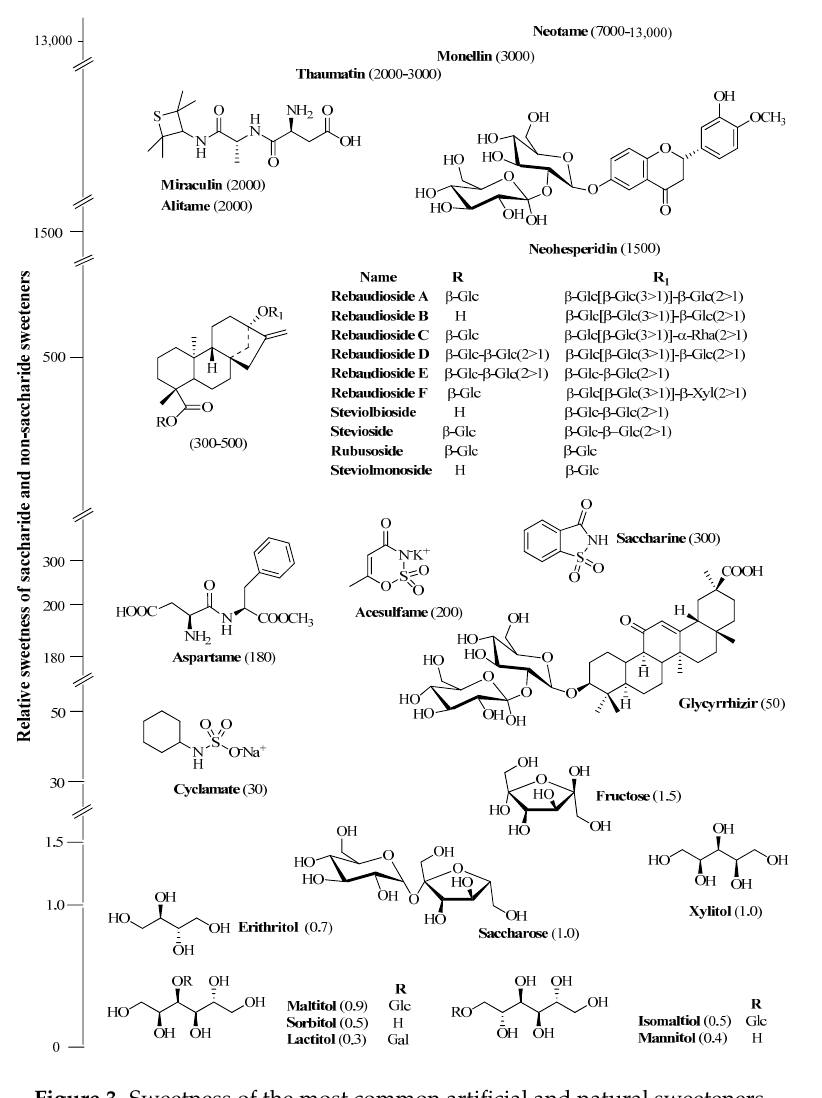
Figure 3. Sweetness of the most common artificial and natural sweeteners. Table 2. Medicinal uses of Stevia species [48,49].